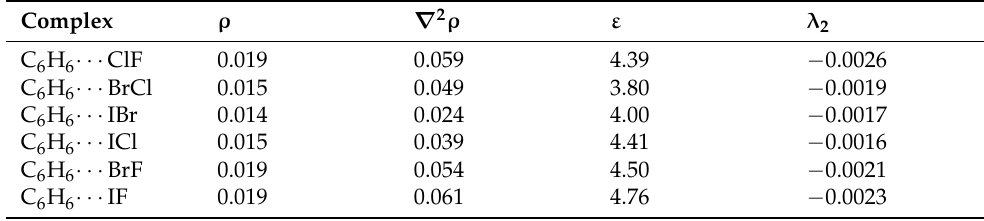
Table 2. The values of electron density ( ρ ), Laplacian of electron density ( (cid:53) 2 ρ ) ellipticity ( ε ) and λ 2 of the saddle